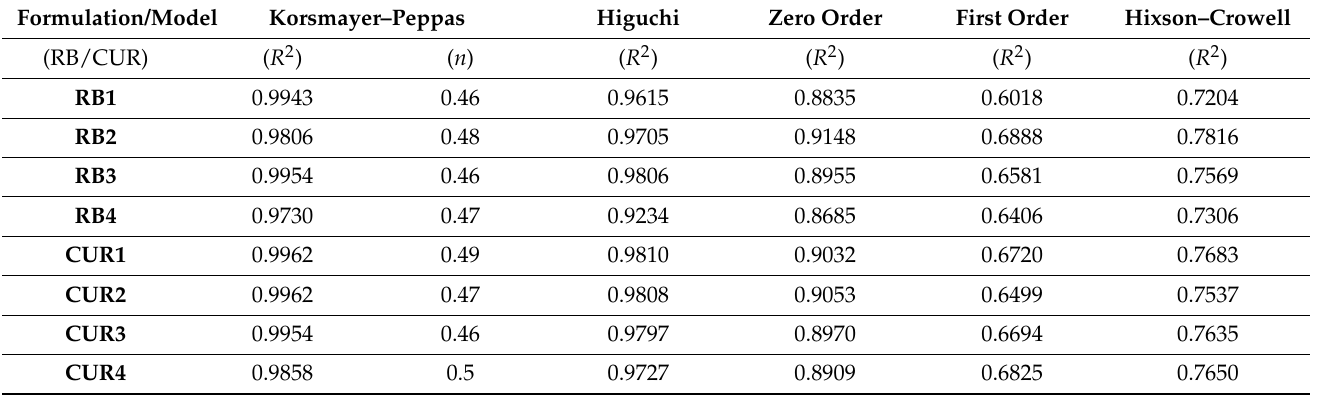
Table 3. Kinetic model analysis of the drug release